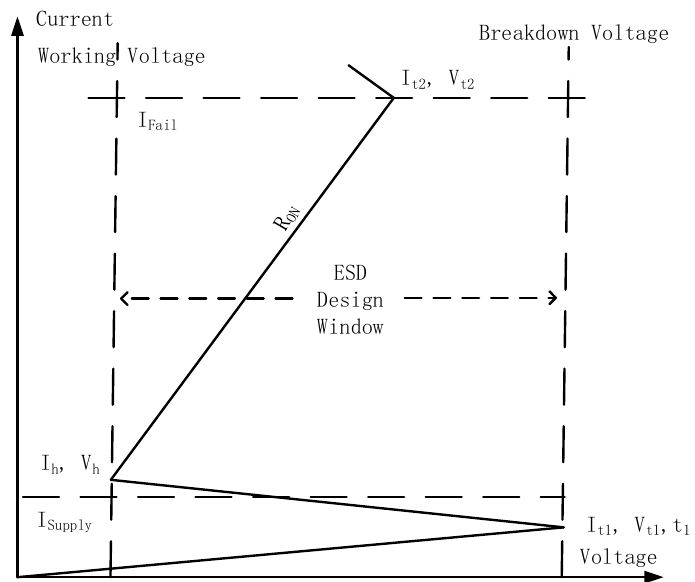
Figure 1. Illustration for a full-chip ESD protection scheme.